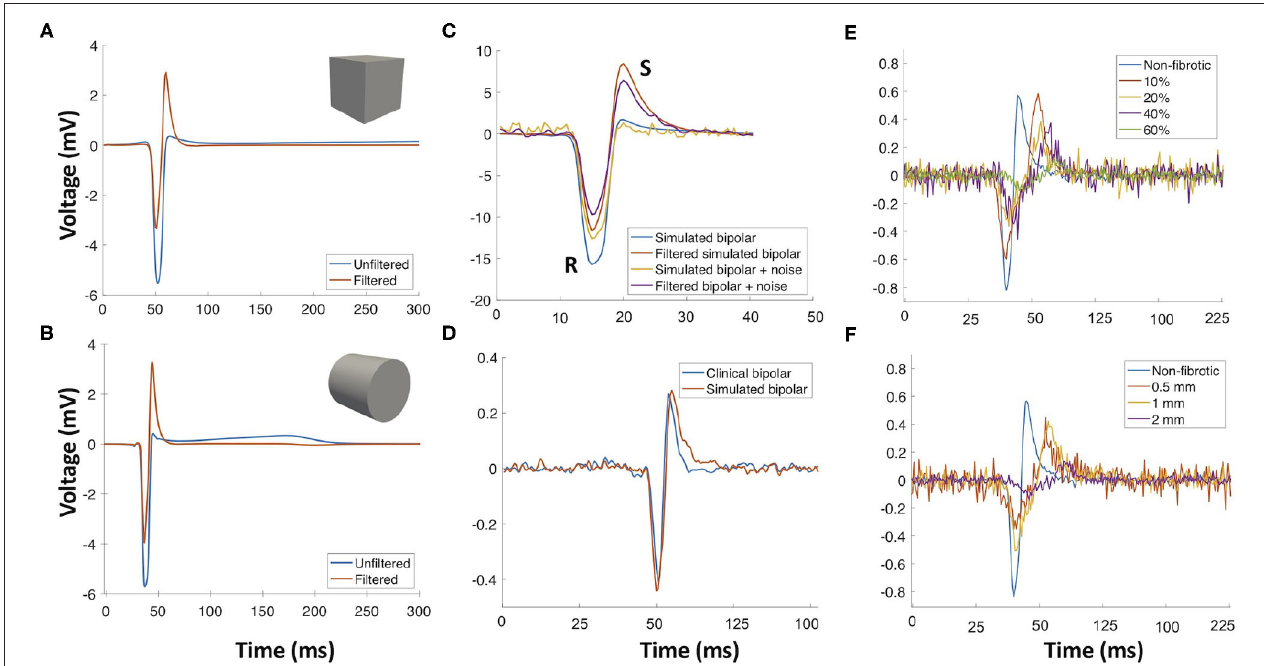
FIGURE 4 | Importance of using a realistic electrode geometry and adding noise for simulated intracardiac signals. (A) Bipolar electrogram signal recorded with a cubic electrode (blue trace) and the corresponding filtered signal (red trace). (B) Signal recorded with a cylindrical electrode (blue trace) and the resulting signal after filtering (red trace). (C) Simulated signals recorded with a cylindrical electrode with and without noise and the resulting signals after filtering. (D) Comparison of a simulated signal with a clinical signal. (E) Electrograms recorded on the surface of the fibrotic tissue with different densities. (F) Effect of fibrosis growth from the endocardial surface to the epicardium (0.5, 1, 2mm) on the electrogram (60% fibrosis density). Reused from Sánchez et al.